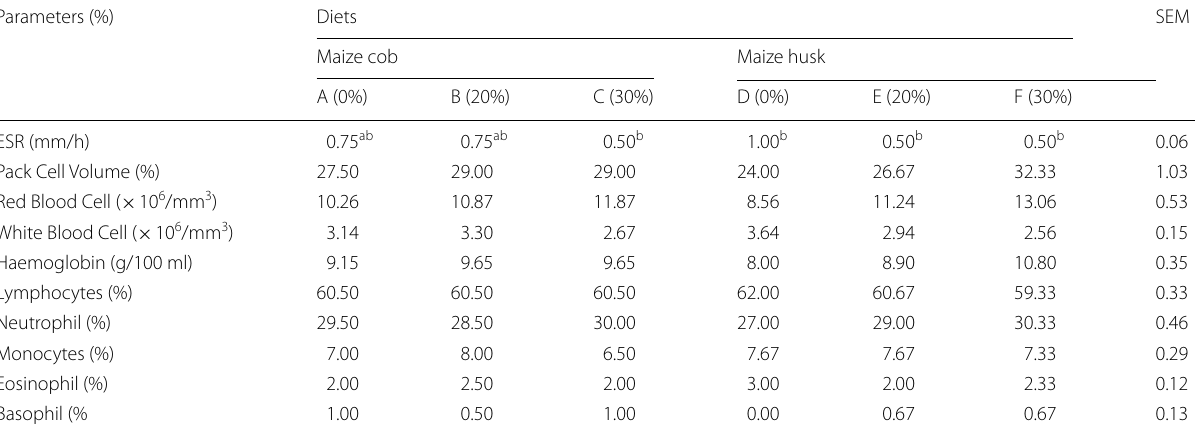
a, b means within the same row with different superscripts are significantly ( P < 0.05) different =